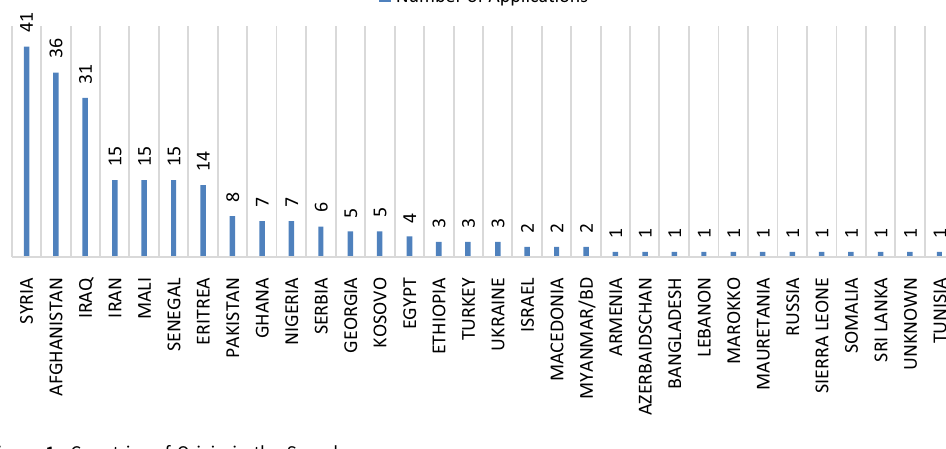
Figure 1. Countries of Origin in the